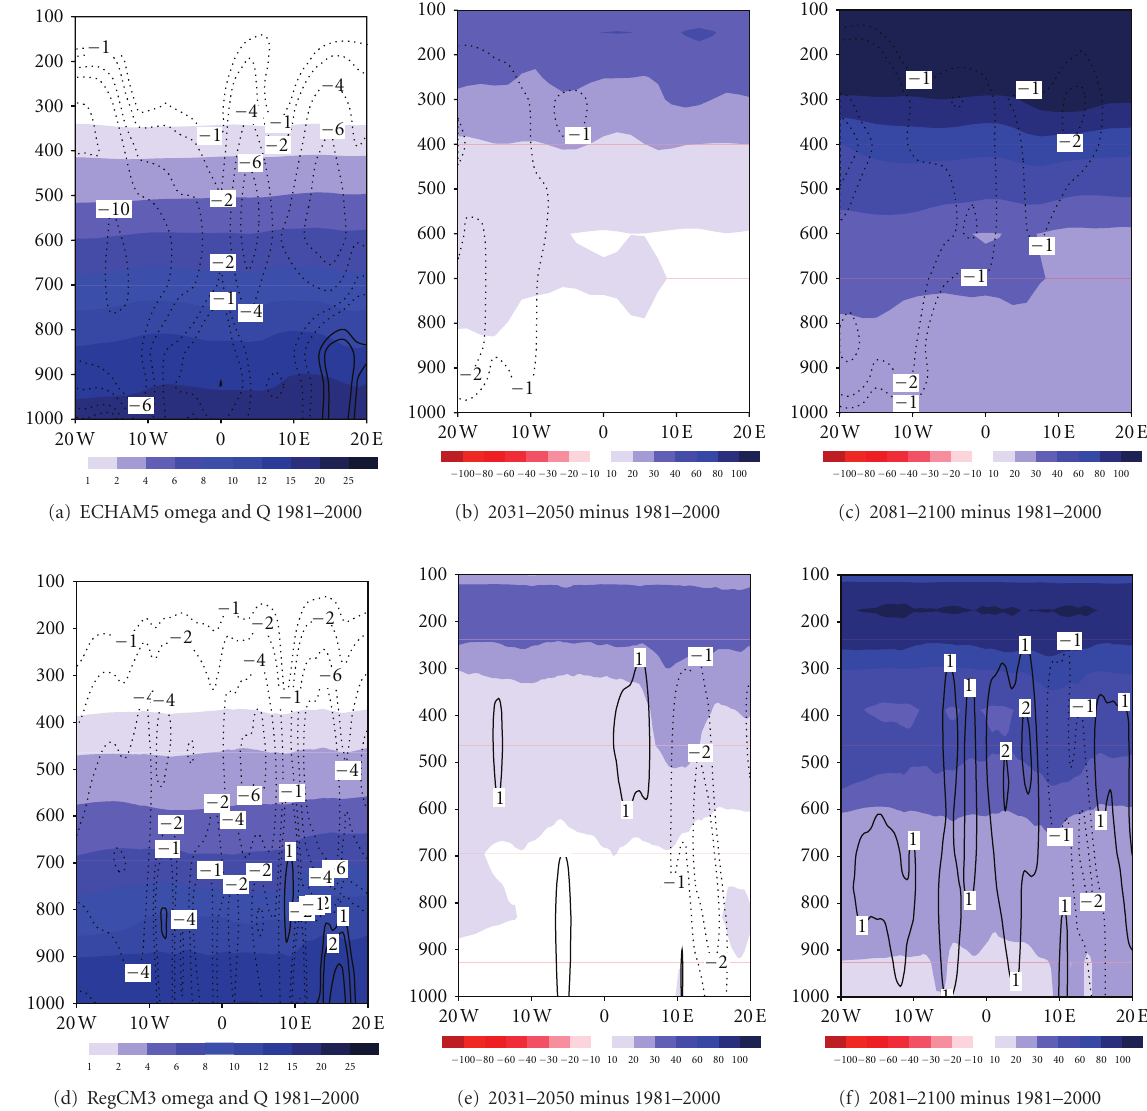
Figure 11: Mean summer (June–August) longitude-height cross-section of specific humidity (g/kg) and overlapping omega (10 − 3 Pa/s) from ECHAM5 (upper) and RegCM3 (lower) during the present day (left), the di ff erence between early 21st century and the present day (middle), and the di ff erence between late 21st century and the present day (right). Negative contours represent regions of ascent, and positive contours are regions of